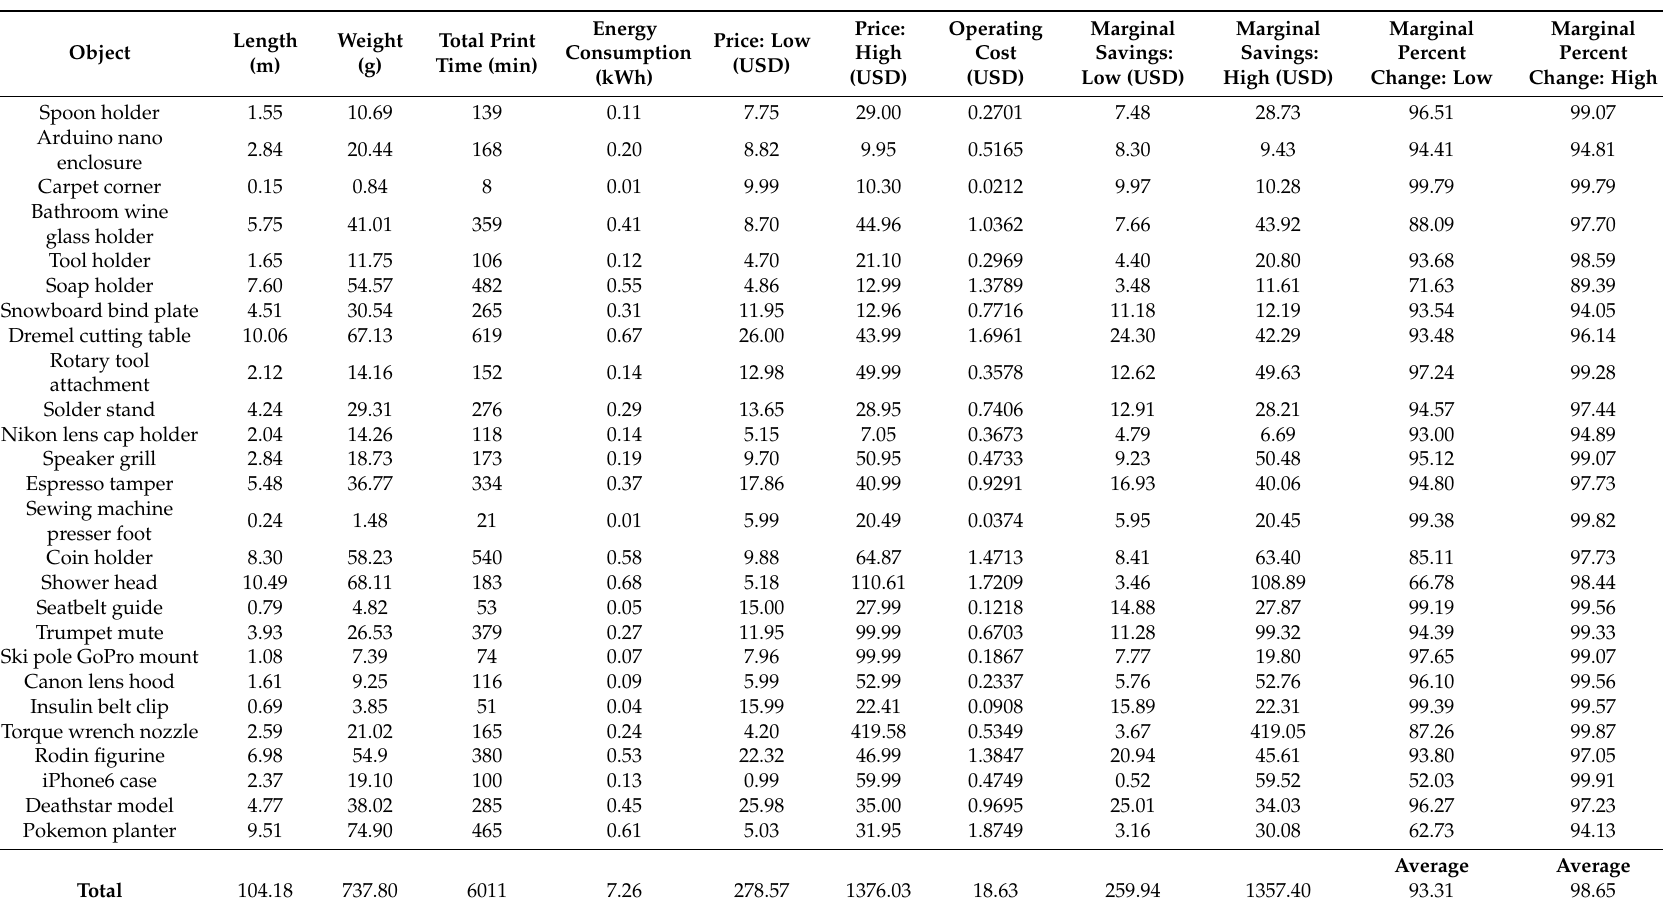
Table 2. 3-D printable object, length of filament, print time, energy consumption, low and high retail price, operating cost, marginal savings, and percent savings for 26 freely available